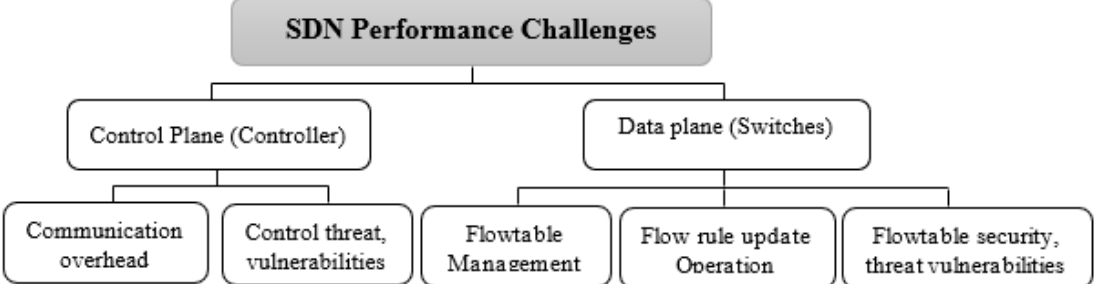
Table 1. Number of article publications from research libraries.